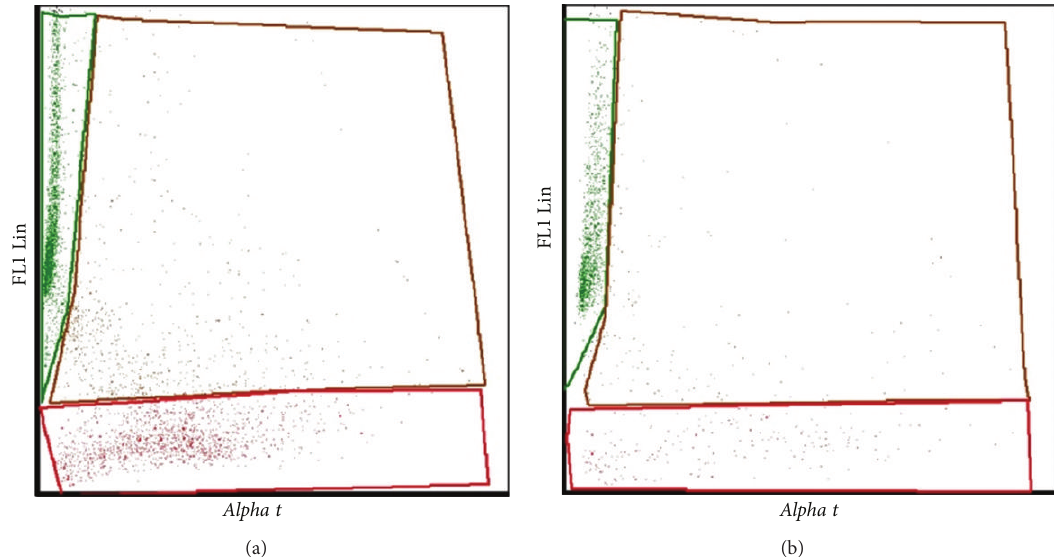
Figure 2: Scatter plots of SCSA analysis of a sperm sample with DFI ≥ 30% (a) and DFI < 30% (b) showing the ratio of green (not fragmented) and red (fragmented) sperm. The percentage of sperm with denatured DNA is reported as Comp alpha t (cells outside the main population).